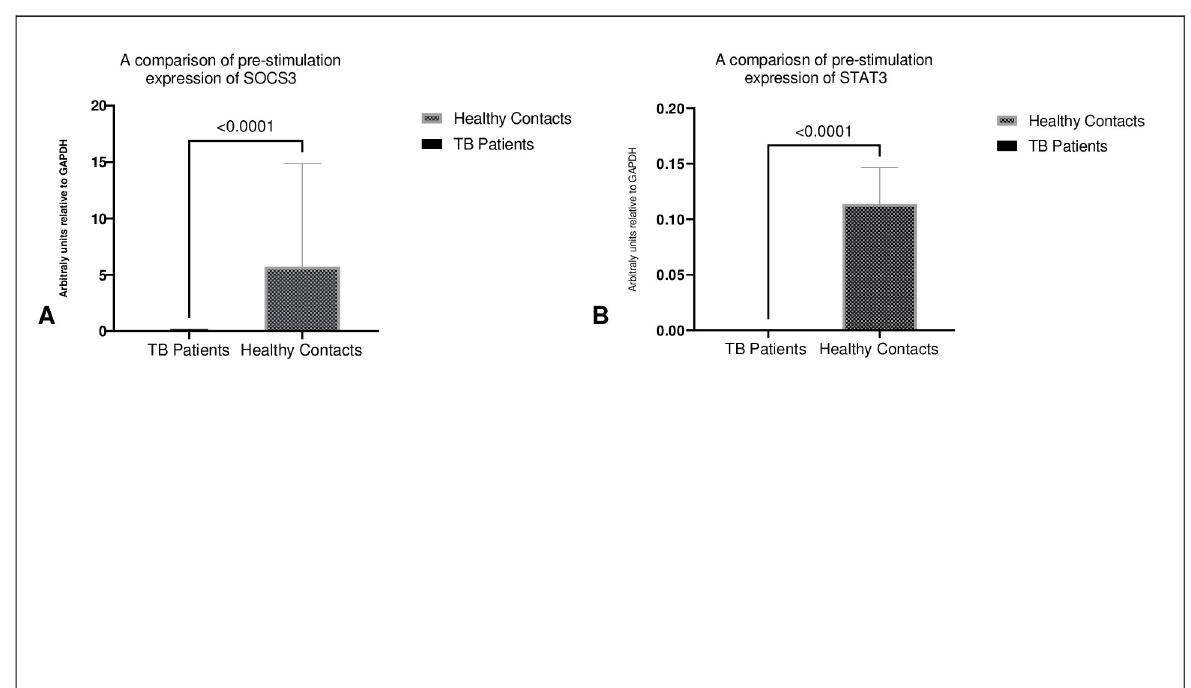
Fig 2. Shows the comparison of SOCS3 and STAT3 expression pre-stimulation in TB patients vs healthy contacts. A: Shows statistically significant higher levels of SOCS3 in healthy contacts when compared to TB patients. Median (IQR) 0.0 (0.0–0.0) in TB patients vs 1.4 (0.4–6.9) in healthy contacts, p value = < 0.0001. B. Shows the hardly any expression of STAT3 pre-stimulation in both TB patients and healthy contacts. Statistical significance evaluated using Mann–Whitney test.